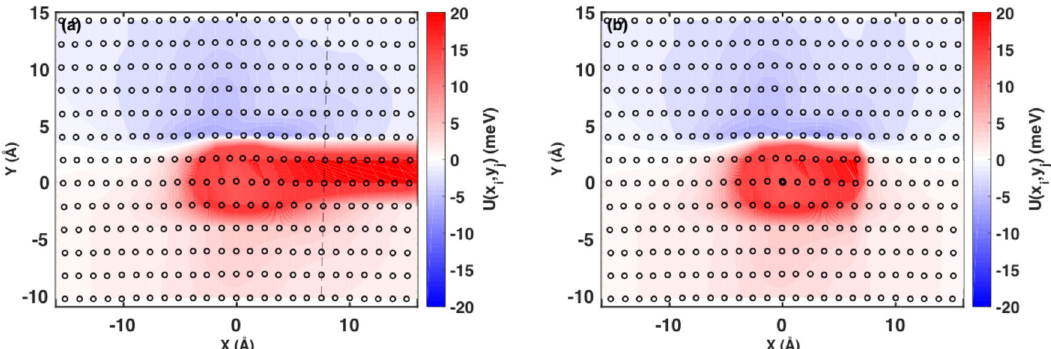
Fig. 7 The Ni solute interaction energy map with a partial dislocation in fcc Co. a Shows the calculated solute-dislocation interaction energy map, while ( b ) shows the modi fi ed solute-dislocation interaction energy map to eliminate the stacking fault interactions. We discard the interaction energies to the right of the dashed line and assigned the interaction energy to the sites on the right of the line such that the values are symmetric with respect to the partial dislocation center.